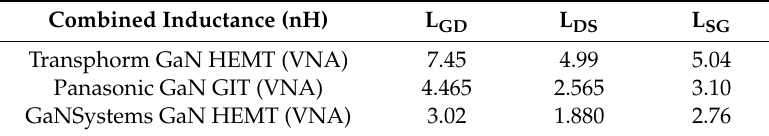
Table 2. Measured lumped inductance of the terminals of the devices.